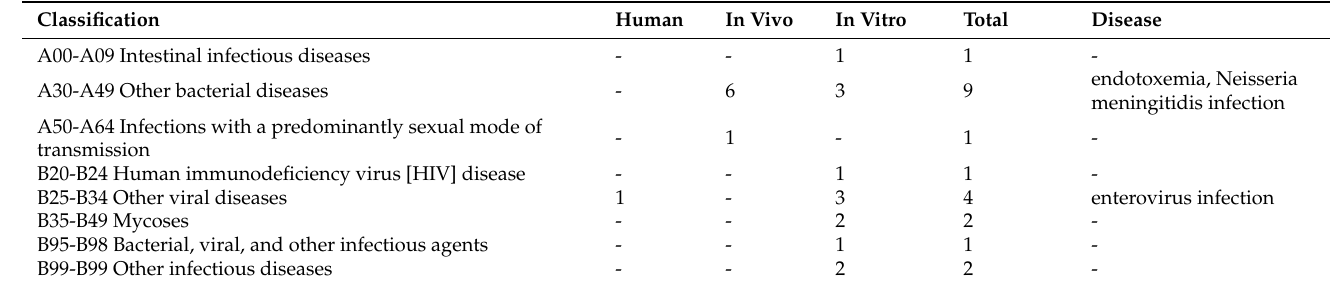
Table 12. The statistics of pharmacological results and its major diseases of SMC by experimental type in I Certain infectious and parasitic diseases of